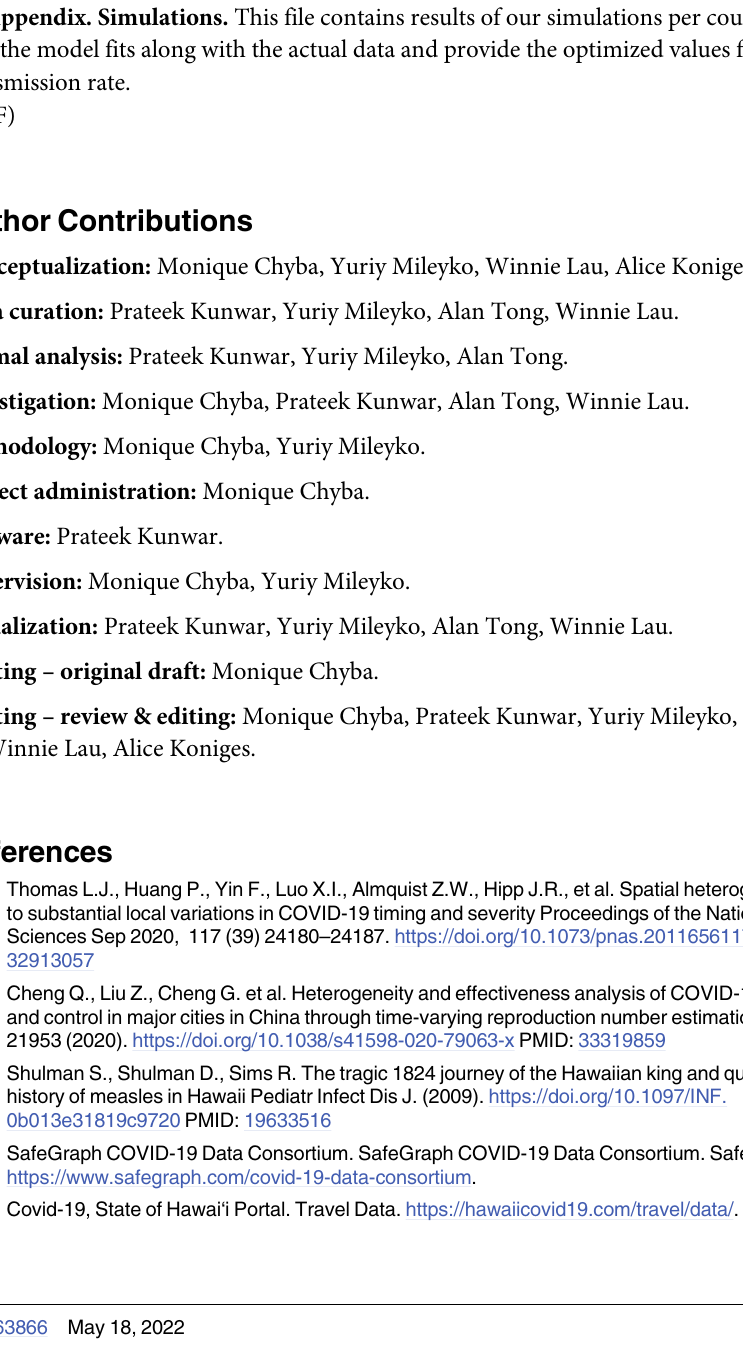
S2 Table. Data for travelers. The table provides the estimates used in our model for travelers for the State of Hawai‘i and comparing countries since the beginning of the Safe travel